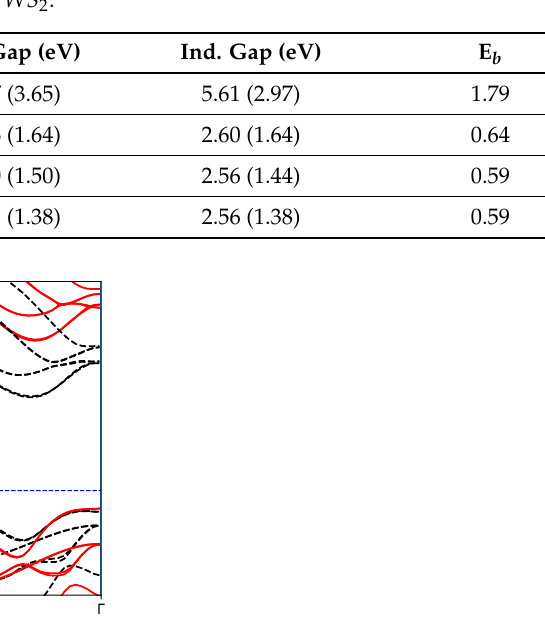
Figure 2. Band structure for the relaxed AlN / WS 2 vdW heterostructure along the high-symmetry path of the first Brillouin zone calculated within DFT (dashed black) and G 0 W 0 (continuous red) level of approximation, taking into account the spin-orbit interaction. Notice that the minimum of the conduction bands appears between Γ and K , close to the Q point, and together with the top of the valence band at K forms the indirect band gap. The zero energy is set at the top of the valence bands in both the DFT and G 0 W 0